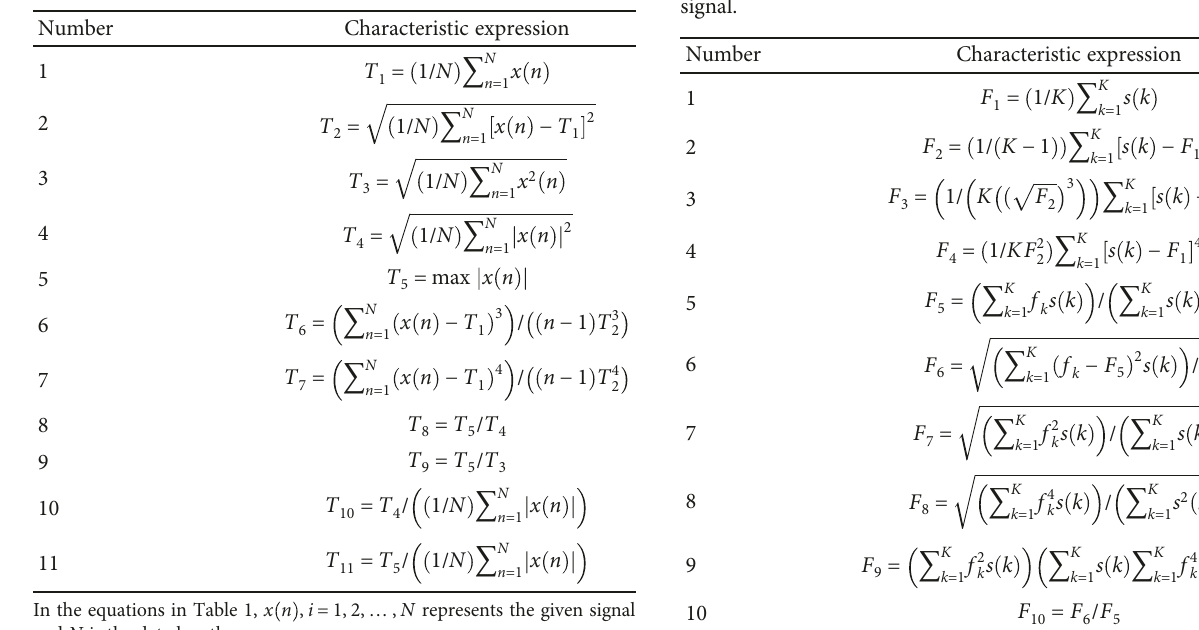
Table 1: Time domain feature vectors of vibration